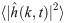
Log–log plot of the (k, −1/λ(k)) of full model, which should reflect the power spectrum 〈|h^(k,t)|2〉.The distribution shows linearity in the parameter range without spontaneous pattern formation, indicating λ ∝ k−γ.